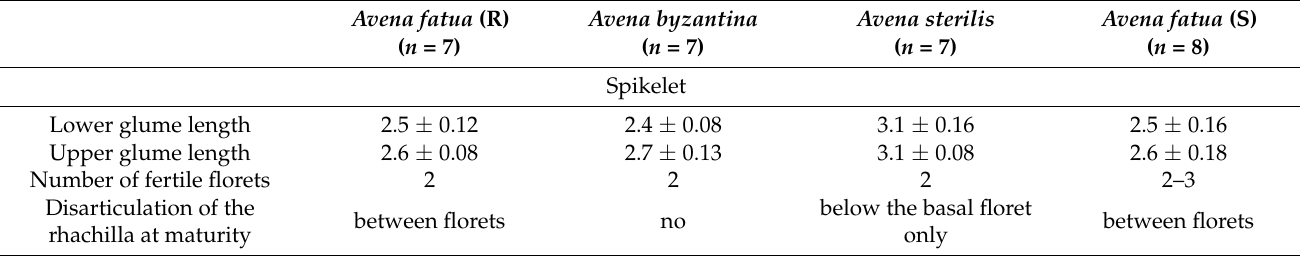
Figure 1. Spikelets and lemmas from flowering plants of the studied A. fatua (R), A. byzantina , A. sterilis and A. fatua (S). Rows depict ( 1 ) spikelets, ( 2 ) basal, twisting portions (columns) of lemma’s dorsal awns, and ( 3 ) distribution of hairs in the basal half of lemmas of spikelet’s lowermost flowers. Note that in A. byzantine, the awn lacks a definite column, and hairs are only present at the lemma base. Table 1. Biometric analysis of diagnostic traits on plants individually grown in pots of the four Avena accession studied. Mean values (in cm) and standard deviations are offered for continuous quantitative traits. One spikelet per plant was randomly selected. The number of plants sampled per accession is indicated between